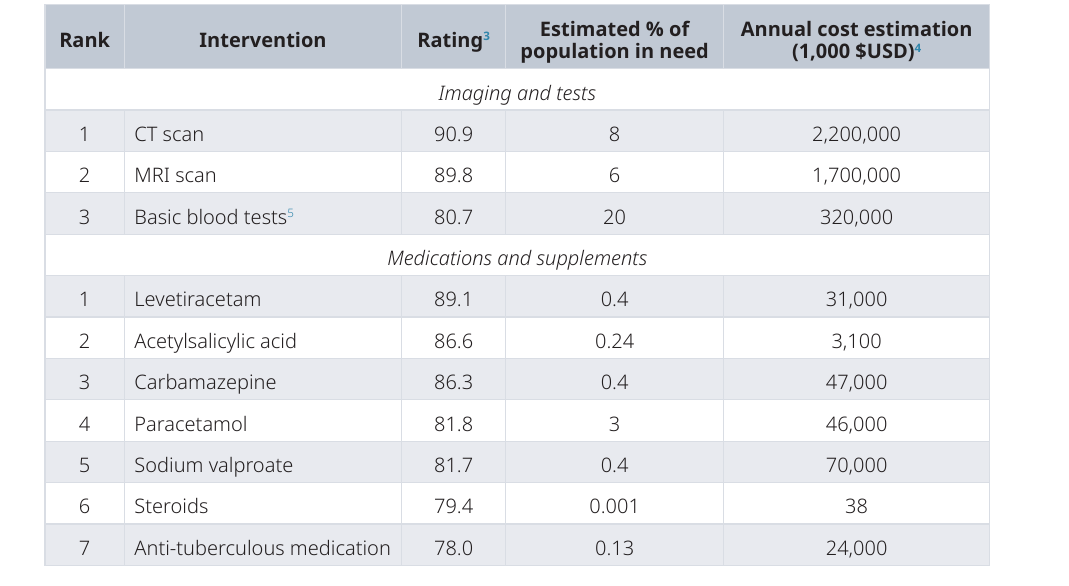
Table 4. Highest ranked neurological interventions for displaced